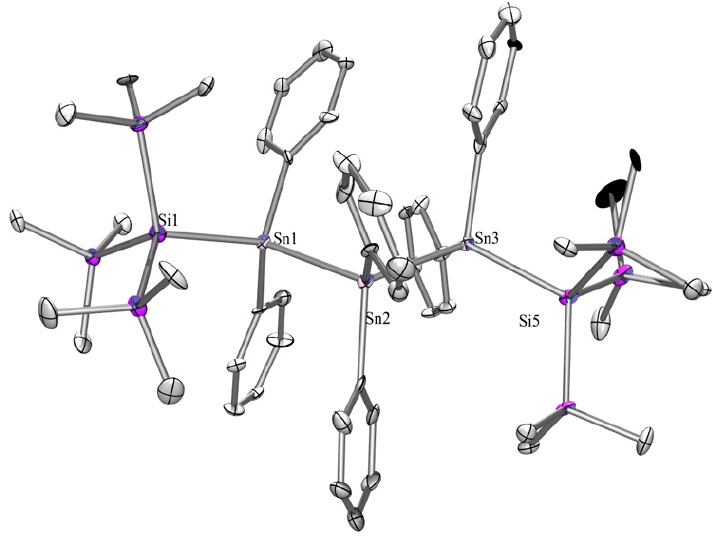
Figure 4. Molecular structure of 6a (thermal ellipsoid plot drawn at the 30% probability level). All hydrogen atoms are not shown for clarity (bond lengths in Å, angles in °). Sn(1)–C(16) 2.151(14), Sn(1)–Si(1) 2.583(4), Sn(1)–Sn(2) 2.8022(15), Sn(2)–Sn(3) 2.8161(14), Sn(3)–Si(5) 2.608(4), Si(1)–Si(2) 2.358(6), Si(2)–C(1) 1.885(18), Si(1)–Sn(1)–Sn(2) 123.01(11), Sn(1)–Sn(2)–Sn(3) 111.38(4).